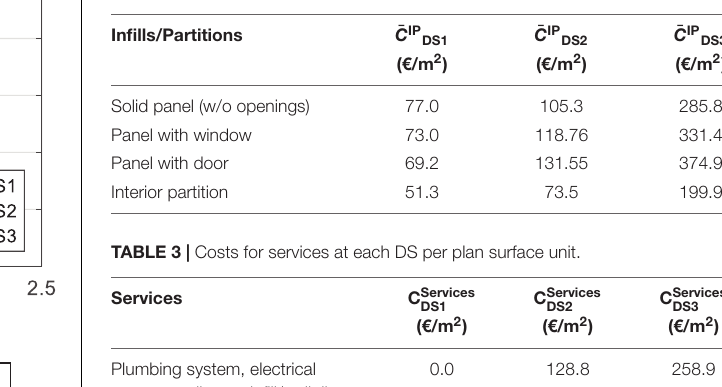
TABLE 2 | Repair costs for double leaf hollow clay bricks for infills/partitions (IP) at each DS per infill panel surface unit.